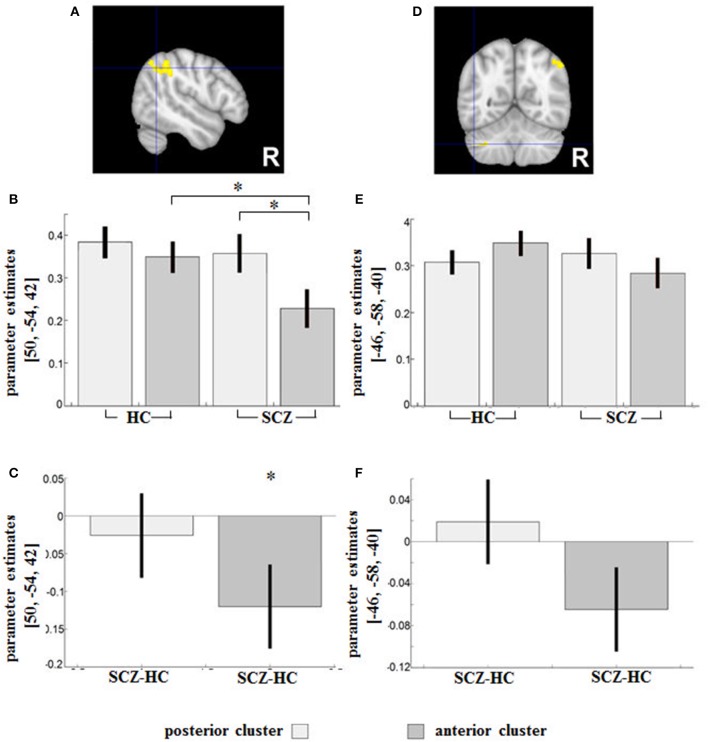
Regions showing an SCZ-related (relative) decreased functional connectivity with the anterior DLPFC compared to the posterior seed were (A) the right IPL (Area PGa) and (D) the left cerebellum. Contrast estimates for the effect in the respective region (B,E) and the difference (SCZ—HC) in RSFC between HC and SCZ for the posterior and anterior DLPFC seeds respectively (C,F) are demonstrated below. *indicates the significant effects of the interaction assessed with t-tests (p < 0.05 family-wise error (FWE)-corrected on the voxel level).